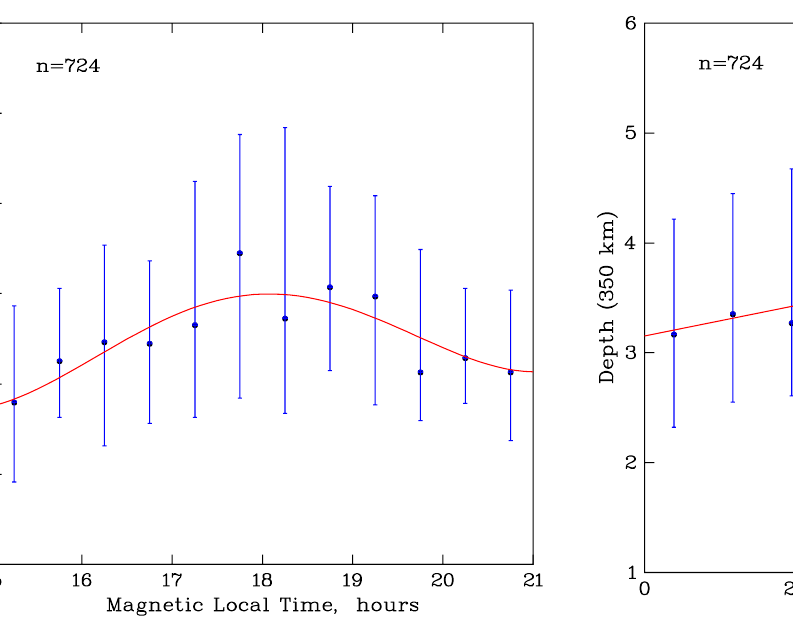
Fig. 8. Magnetic local time dependent changes in the magnitude of the density drop in the equatorward trough wall. The format of data presentation corresponds to that of Fig. 6 except that the height is replaced by the magnetic local time. The regression curve fitted to the median values is given in Eq. (7). All data have been adjusted to a common reference altitude of 350km.